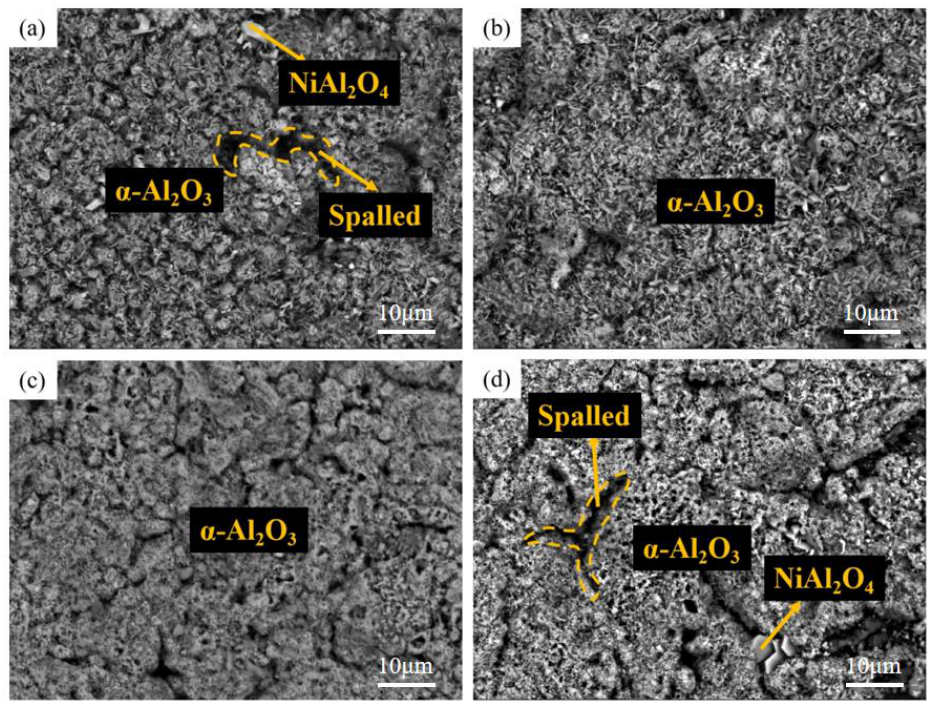
Figure 9. Oxidation morphologies of coatings under different pre-oxidation temperatures at 1000 °C for 300 h: ( a ) untreated; ( b ) 900 °C; ( c ) 950 °C; ( d ) 1000 °C.